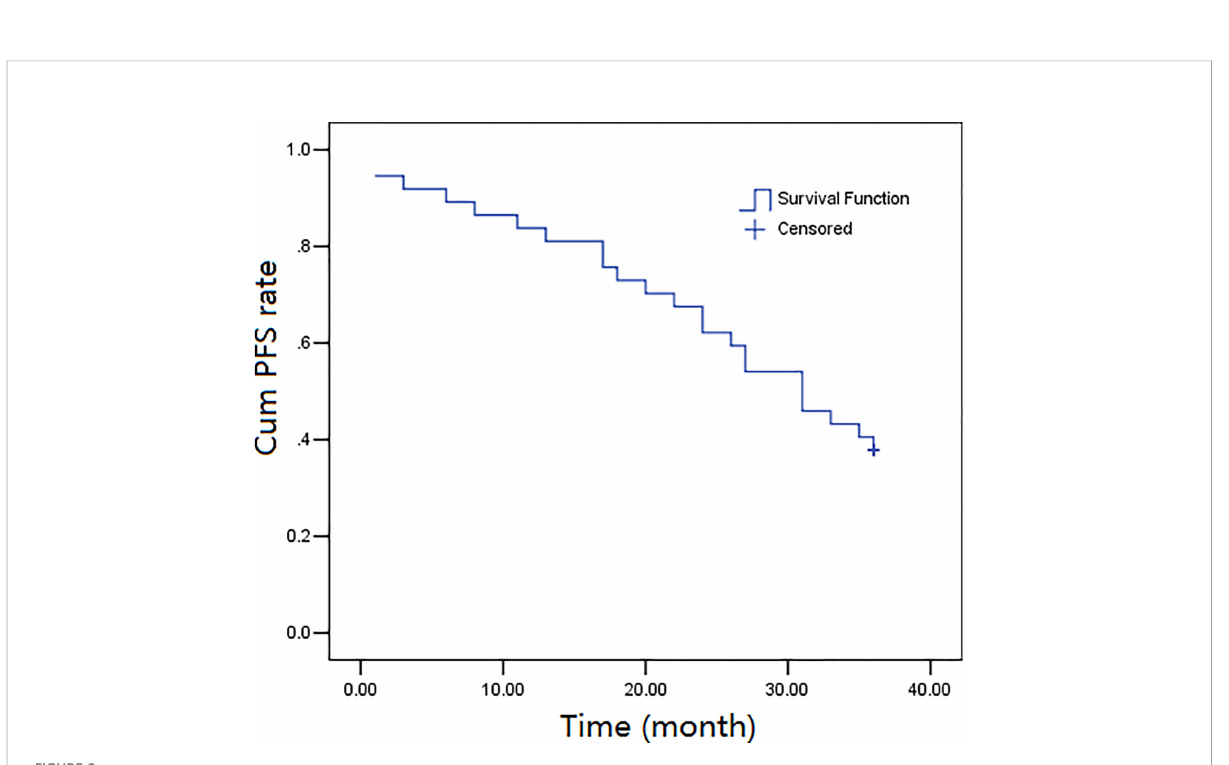
FIGURE 2 Kaplan-Meier progression-free survival (PFS) curves for 37